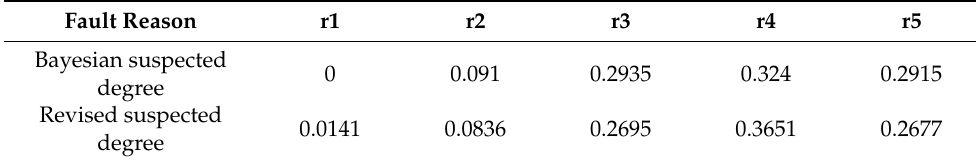
Table 8. Suspected degree of fault